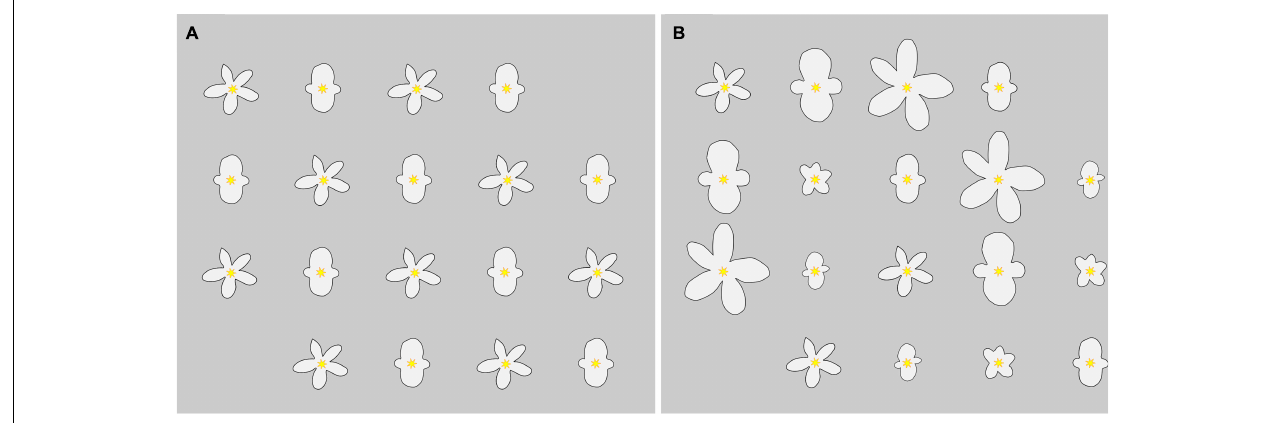
FIGURE 4 | Two possible arrangements of flowers in a 5 × 4 Cartesian grid design for the two treatments. In the (A) no corolla size variation treatment (“control treatment”), all artificial corollas were modeled after medium-sized B. odorata male and female flowers, alternated by position. In the (B) corolla size variation treatment (“variation treatment”), artificial corollas were modeled after small, medium, and large-sized B. odorata male and female flowers, alternated by position in terms of reproductive organs and with size classes systematically distributed equivalently across the array.